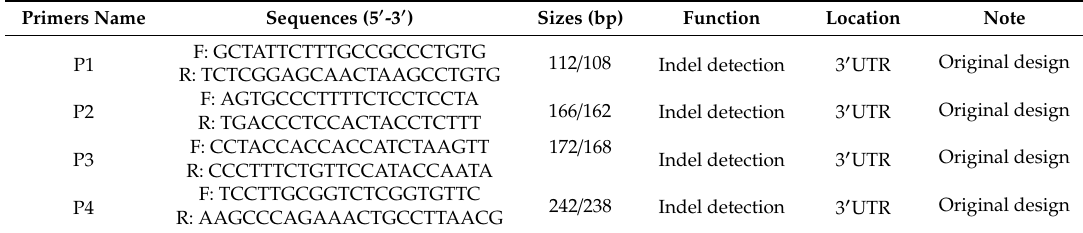
Table 1. Primers for PCR amplification of SRY-type HMG box 9 ( Sox9 )